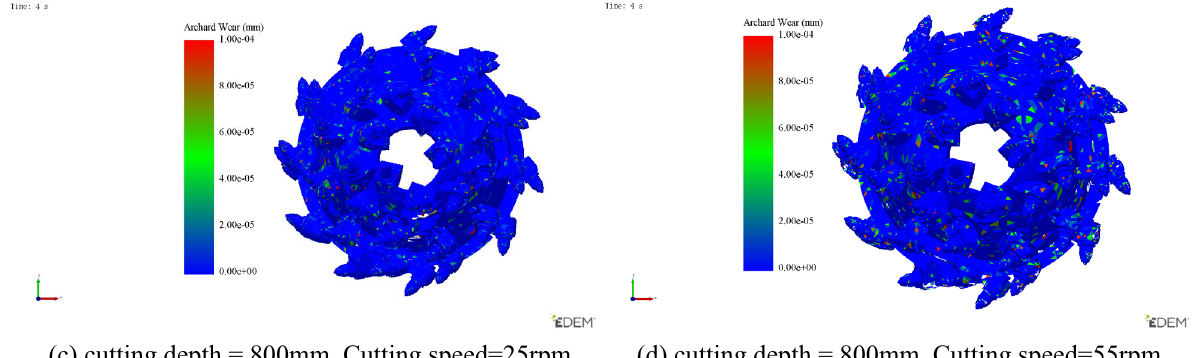
Figure 19. Nephogram of wear depth of cutting head under different cutting parameter.